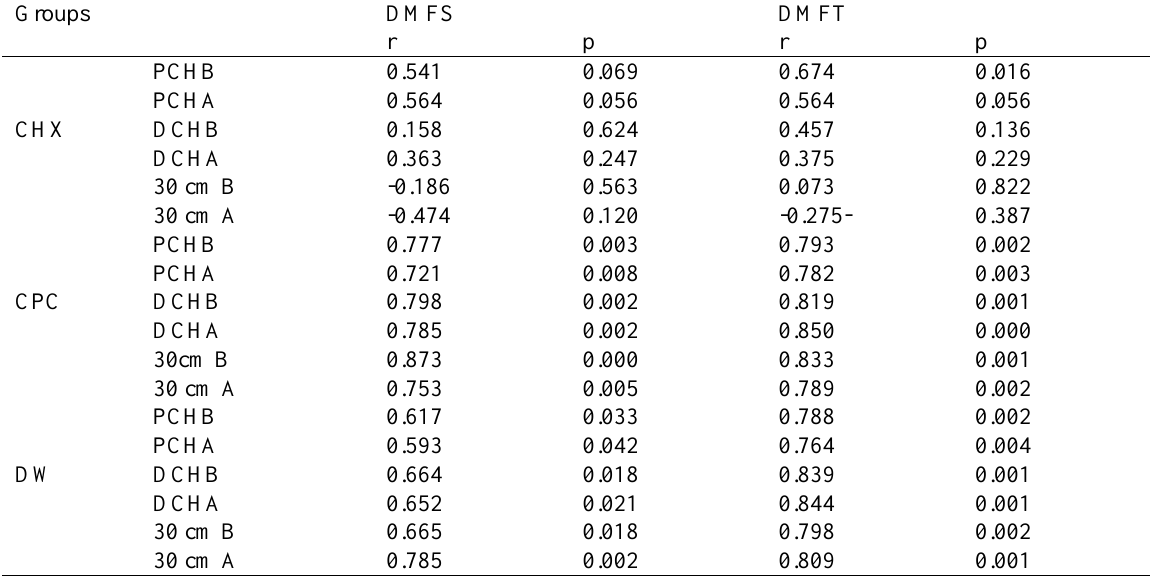
Table 1: The statistical correlation between caries experience (DMFS, DMFT) and the colony count of aerosol bacteria in all mouthwashes groups, locations and periods.